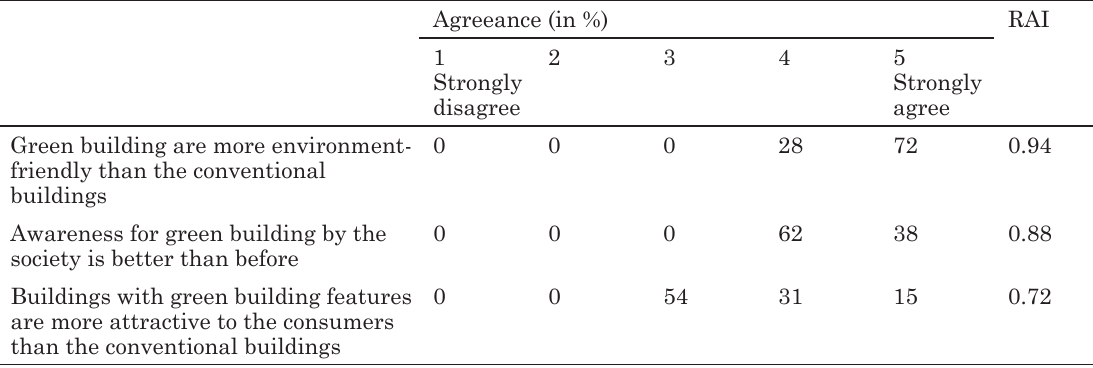
table 2. summary of survey results on social